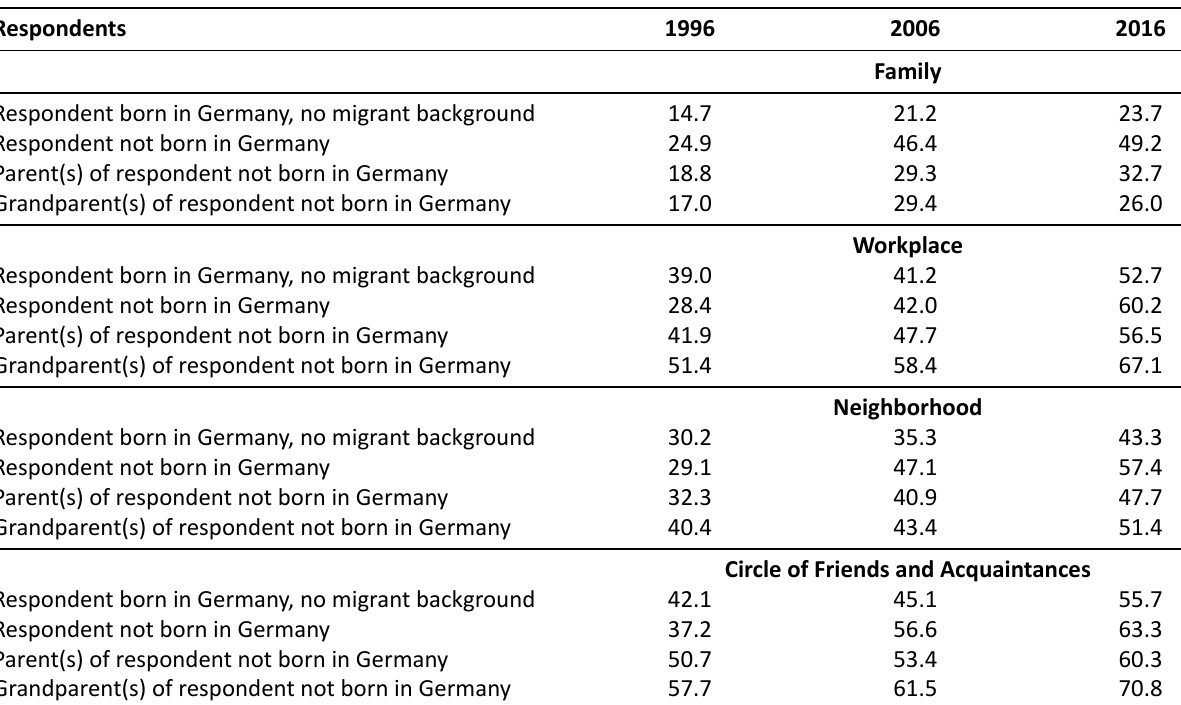
Table 2. Percentage of respondents that had personal contact with foreigners residing in Germany in various areas of life. Source: GESIS (2019a).